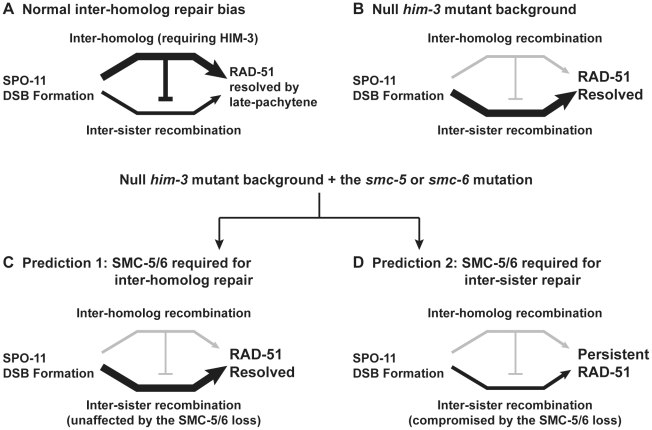
Possible outcomes for the combined genetic disruptions of smc-5 or smc-6 and him-3.(A) Schematic diagram depicts the biased repair of SPO-11 DSBs via inter-homolog recombination repair in meiosis. (B) In the absence of HIM-3, SPO-11 DSBs are repaired via homolog-independent (i.e. sister-chromatid) recombination [48]. (C–D) Two predicted repair outcomes for the double mutants. (C) If the SMC-5/6 proteins function mainly in inter-homolog repair which is already disrupted by the him-3 mutation, then the overall repair efficiency as monitored by the removal of RAD-51 staining should be the same in the double mutants as compared to the smc-5 and smc-6 single mutants. (D) If the SMC-5/6 proteins function mainly in inter-sister repair, then the double mutant should exacerbate the repair defects and the RAD-51 intermediates should persist at late pachytene.